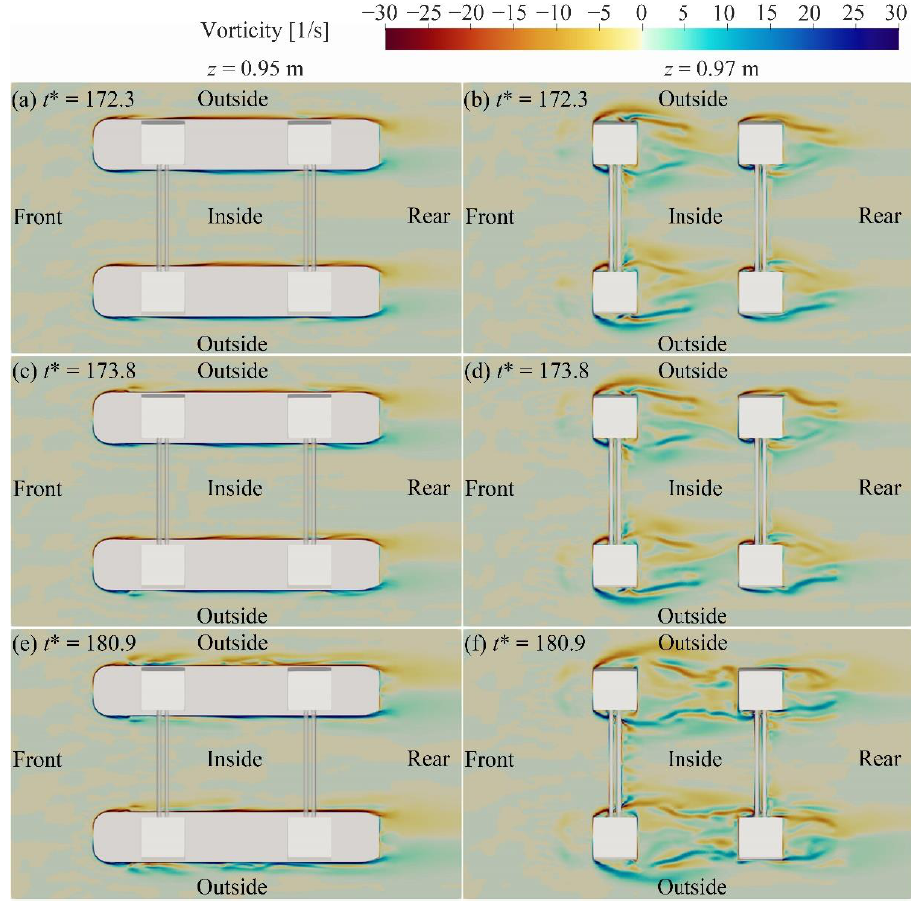
Figure 9. Vorticity around the platform at z = 0.97 m and z = 0.95 m for Case A2.